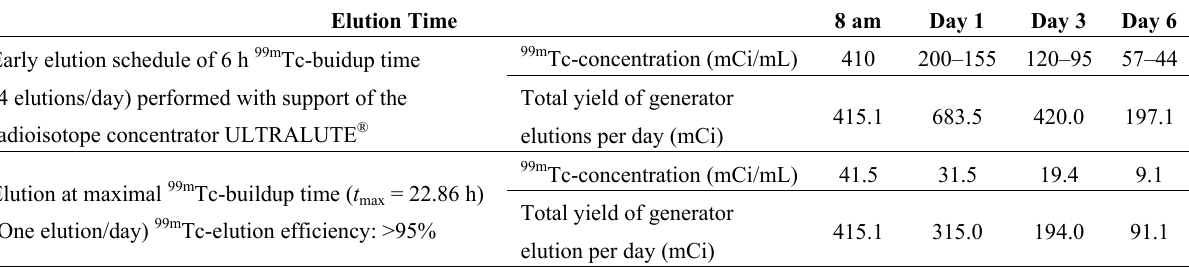
Table 2. Effectiveness of 99m Tc elution performed with an early elution schedule supported by a radioisotope concentrator in comparison with that normally eluted at the time point of maximal 99m Tc-build-up; Generator activity at calibration day (day 1, 8:00 am) is 525 mCi 99 Mo or 459.4 mCi 99m Tc; Solvent is 10 mL saline; Generator is coupled with ULTRALUTE